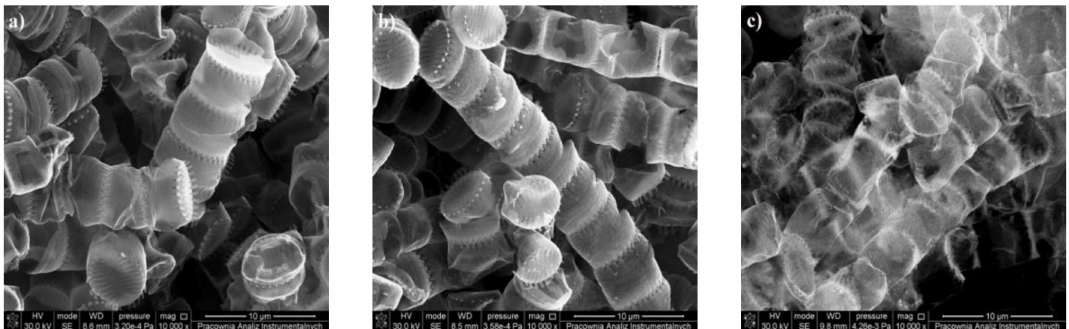
Figure 2. Scanning electron microscopy images of the diatom biomass carbonized at di ff erent temperatures ( a ) 600 ◦ C ( b ) 800 ◦ C and ( c ) 1100 ◦ C. Table 1. Elemental composition (wt.%) of the diatom biomass pyrolysed at 600 ◦ C, 800 ◦ C and 1100 ◦ C. Treatment Diatom